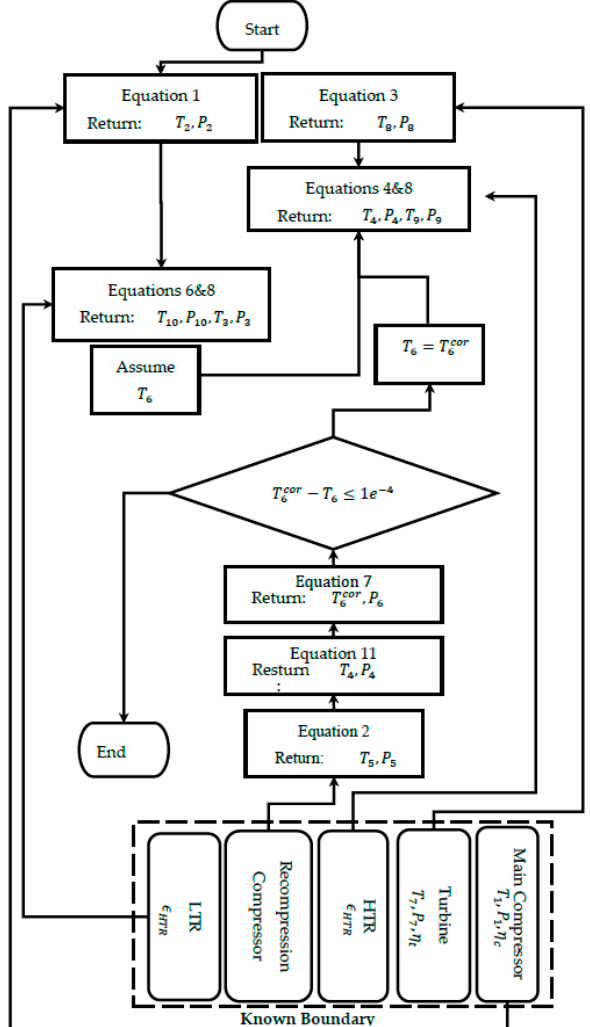
Figure 2. Flowchart of the Matlab code.